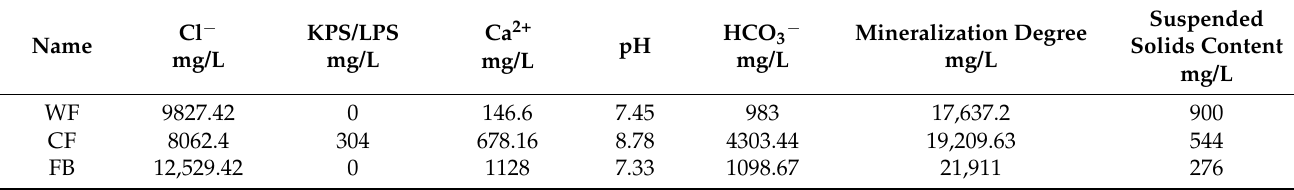
Table 2. Analysis of water contents in WF, CF, and FB emulsion.